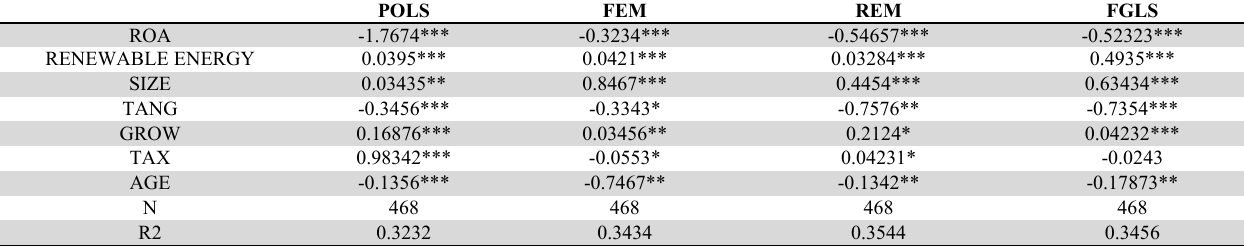
Results of regression models